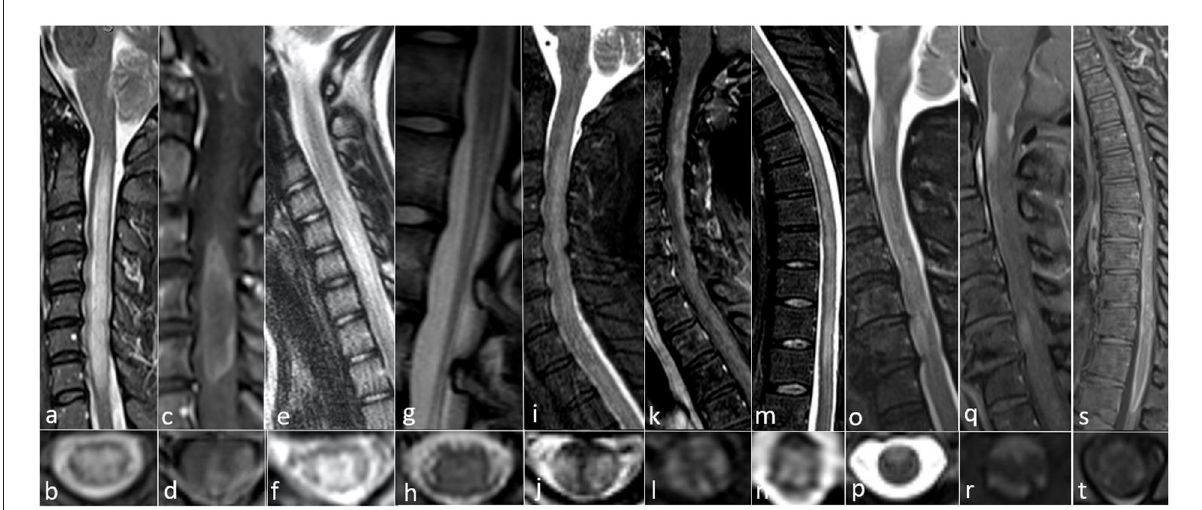
FIGURE1 All images collected from cases seen at the Autoimmune and Neuroimmunology clinics at the University of Colorado. (a–d) AQP4-IgG positive 52-year-old woman with progressive limb weakness and sensory loss with MRI showing (a) sagittal confluent T2 hyperintensity with cord edema from C2 to T1, (b) axial central predominant T2 hyperintense lesion, (c) sagittal ring-enhancement pattern from C3 to C5, and (d) Axial ring enhancement pattern with central and lateral involvement. (e–h) MOG IgG positive 12-year-old-girl with gait abnormality and mild lower extremity weakness with MRI showing (e) sagittal T2 hyperintensity with mild cord edema from C4 to C7, (f) axial gray matter T2 hyperintensity with appearance of an “H” sign, (g) sagittal T2 hyperintensity of the conus medullaris, and (h) Axial subtle symmetric central T2 hyperintensity. (i–n) CRMP5 IgG positive 54-year-old woman with paraplegia, found to have a neuroendocrine carcinoma suggestive of thymus or small cell lung origin and MRI with (i) sagittal T2 hyperintensity with cord swelling from C2 to T1, (j) axial posterior and lateral T2 hyperintensity, (k) sagittal dorsal subpial contrast enhancement from C2 through T1, (l) axial anterior, lateral, and dorsal subpial contrast enhancement, (m) sagittal T2 hyperintensity from T1 to T11, and (n) axial central predominant T2 hyperintensity. (o–t) GFAP IgG positive 63 year old woman with subacute progressive encephalomyelitis with no underlying malignancy and MRI findings of (o) sagittal patchy, extensive ventral T2 hyperintense lesions from the craniocervical junction to C7, (p) Axial ventral T2 hyperintensity, (q) sagittal dorsal and central enhancement at the margin of the craniocervical junction as well as ventral enhancement at the margin of the cord at C3 and C6, (r) axial dorsal and ventral subpial enhancement, (s) sagittal diffuse enhancement of the ventral and dorsal margins of the distal thoracic cord from T8 to T11, and (t) axial ventral subpial